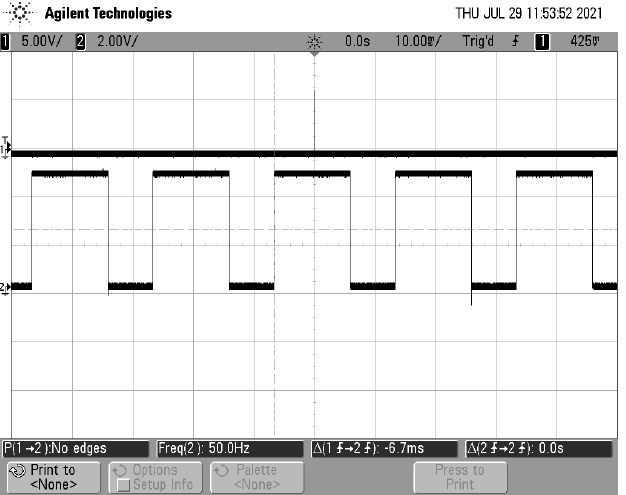
Figure 9. Schmitt -trigger application result for the input voltage signal. In this sample only 1 PPS is seen, but the square signal from the Smith-trigger is clearly observed.